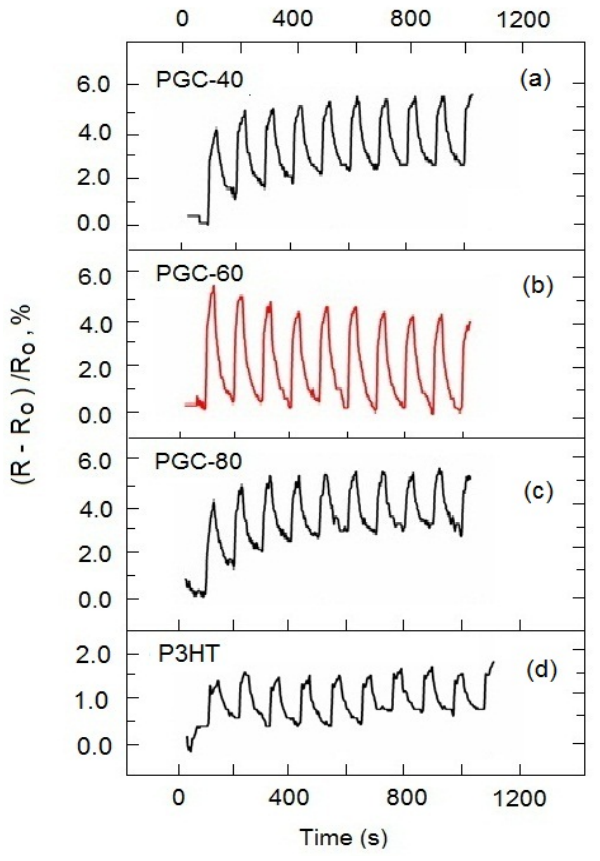
Figure 5. ( a – c ) Sensitivity vs. rGO content in the PGC composite sensors, and ( d ) NH 3 gas sensitivity of pristine P3HT.